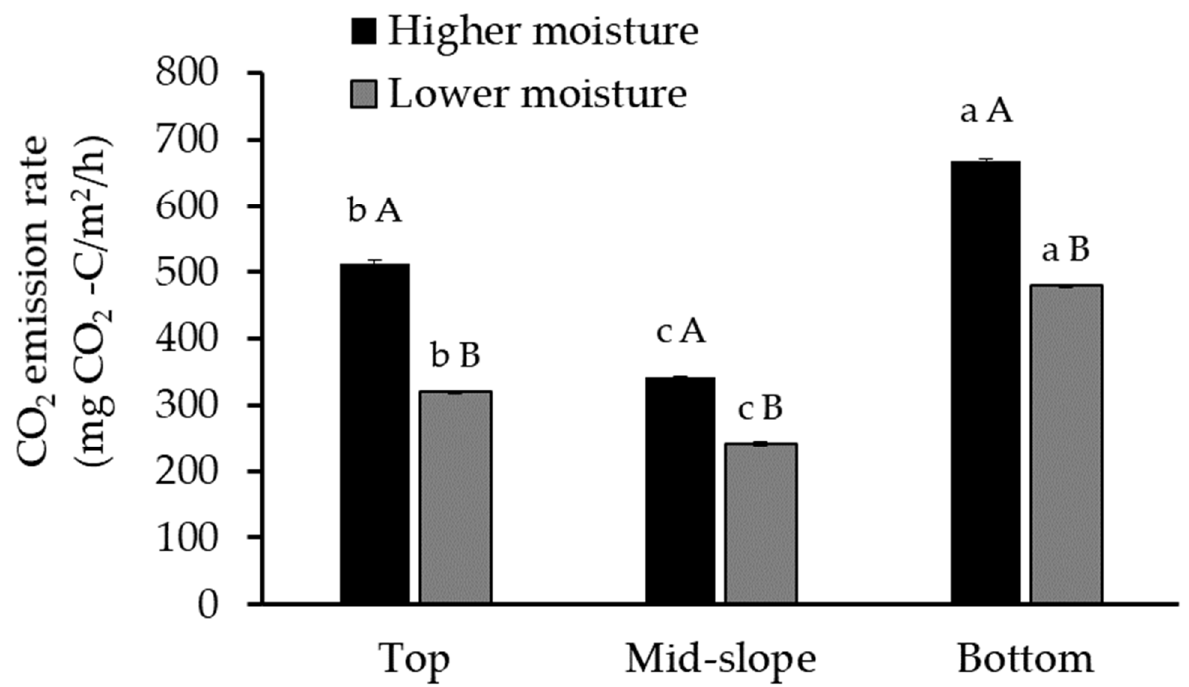
Figure 2. Emissions of CO 2 from soils collected from the top, mid-slope, and bottom of the gully and incubated at high (12% vol.) and low moisture (9% vol.) contents (average values ± sd; n = 3; the same letter indicates no significant differences; the small letters refer to differences between positions, and the capital letters refer to the differences between moisture conditions; ANOVA, Tukey HSD test, p < 0.05).